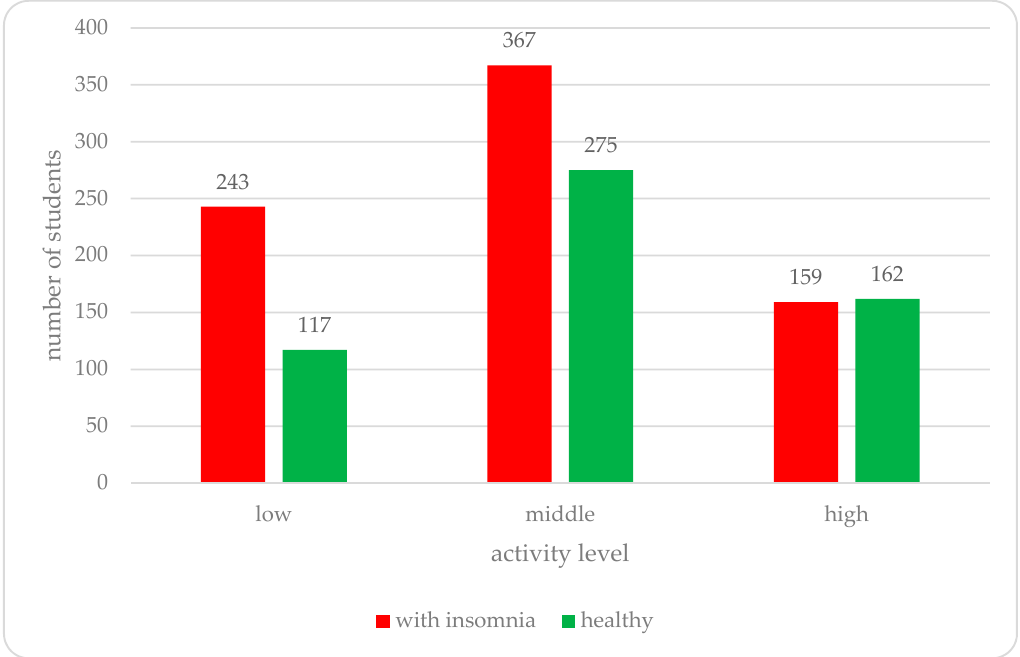
Figure 4. Insomnia prevalence in different activity levels.